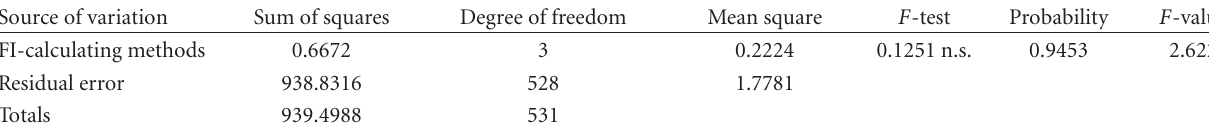
Table 3: Analysis of variance of the four sampling sizes applied to determine the flammability index (FI) through laboratory experimental tests performed on 31 tree and shrub species.